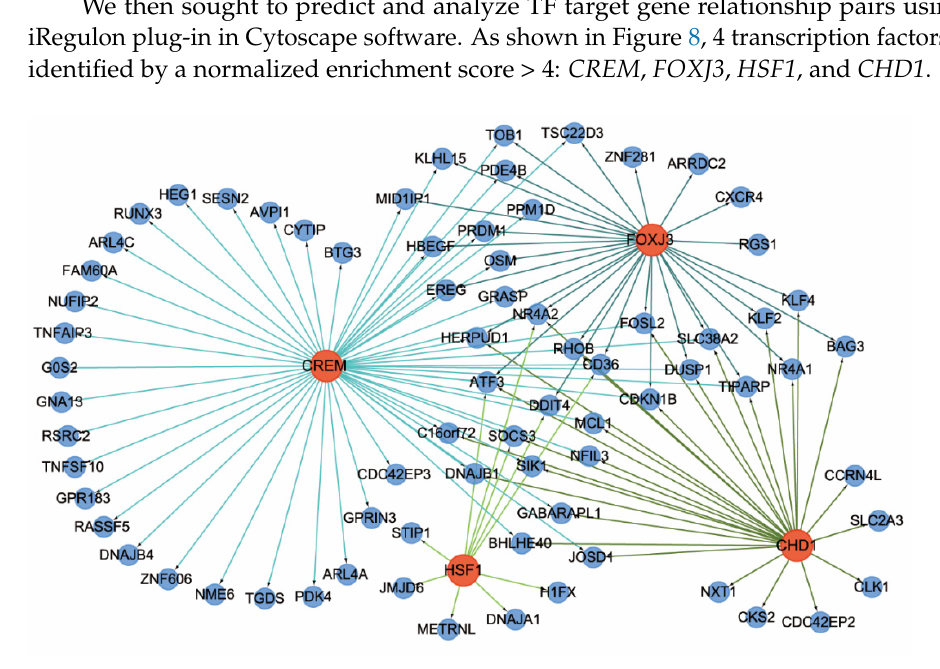
Figure 8. A map of TF target network regulation. Red represents a TF and blue represents the genes; and the arrows connecting the lines indicate the regulatory direction. TF, transcription fac- tor.